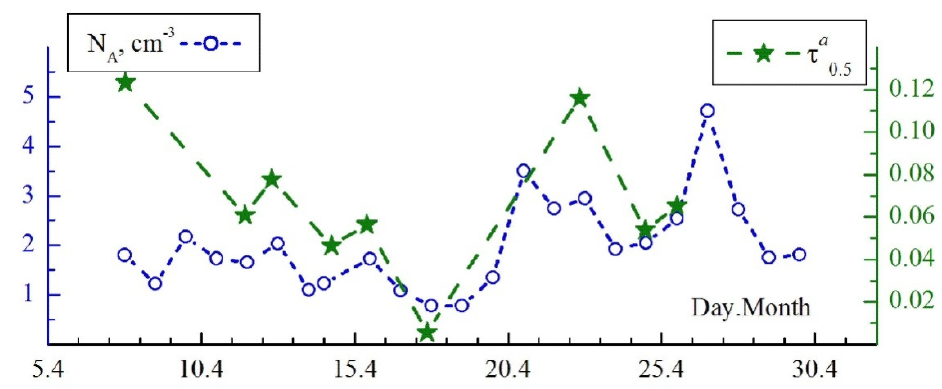
Figure 5. Variations in daily average concentrations N A and AOD in the expedition of RV Akademik Tryoshnikov (drift in ice).